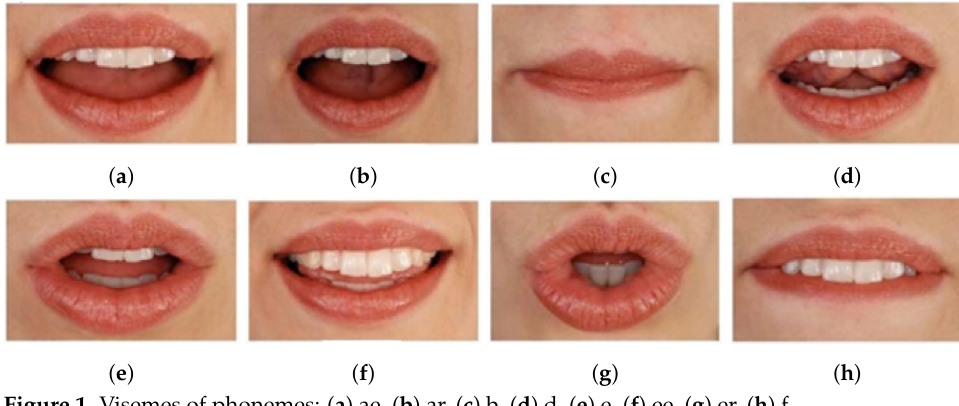
Figure 1. Visemes of phonemes: ( a ) ae, ( b ) ar, ( c ) b, ( d ) d, ( e ) e, ( f ) ee, ( g ) er, ( h ) f. Traditional lip-reading systems work in two steps: feature extraction and